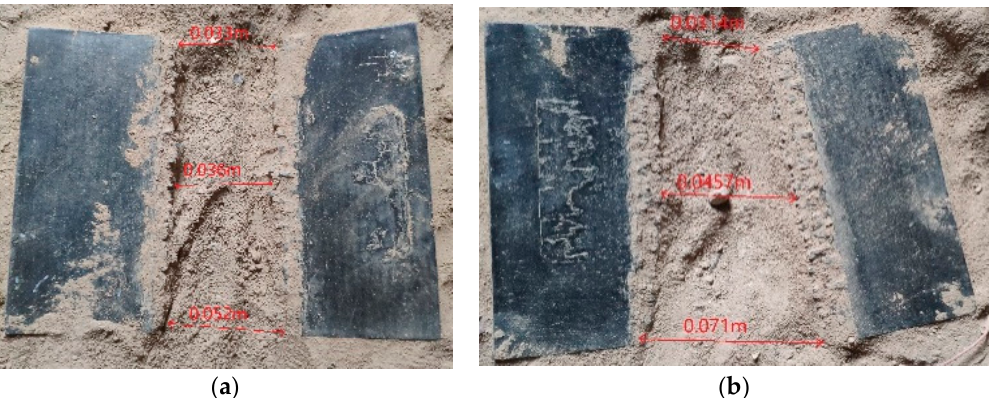
Figure 16. Schematic diagram of the distance between the two parts of the broken board. ( a ) 15 mm; ( b ) 25 mm.